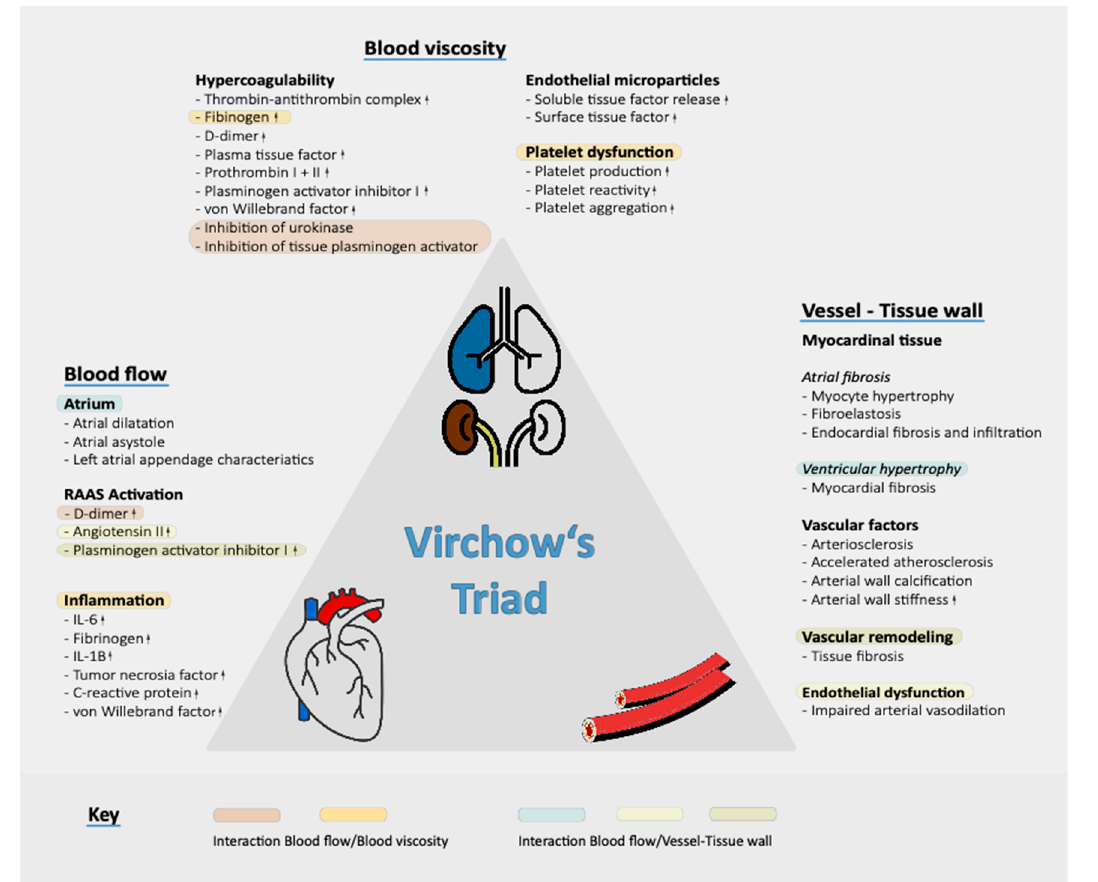
Figure 2. Factors increasing the propensity of thrombus formation in CKD patients.